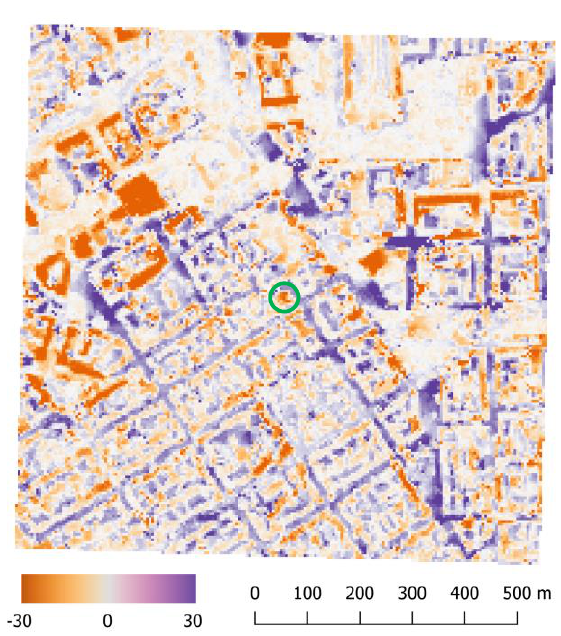
Figure 6: Difference between TanDEM-X derived DEM and ALS DEM represented as 5 by 5 meter grid in the area around Hotel Torni (green circle), Helsinki (center coordinate: 60  10’03’’N, 24 